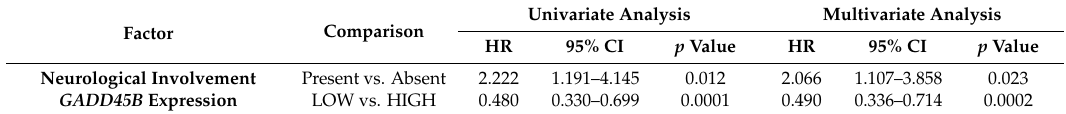
Table 4. Cox analyses of potential prognostic factors for progression ‐ free survival in the stage II CRC cohort.